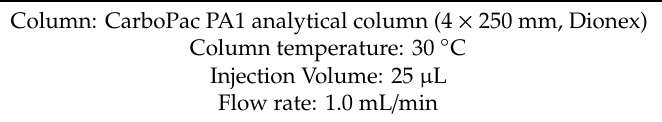
Table 1. High-performance anion-exchange chromatography with pulsed amperometric detection (HPAEC-PAD) operating condition for sugar composition